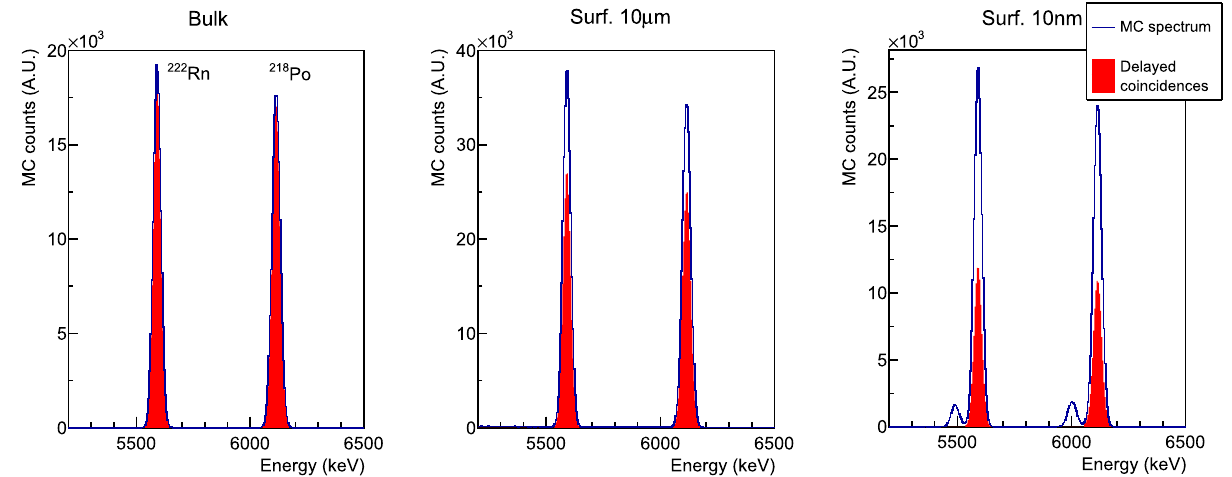
Fig. 5 Monte Carlospectraof 238 Udecaychain, zoomedon 222 Rnand 218 Popeaks,obtainedbysimulatingthecontaminantsinthecrystalbulk (left), and on crystal surfaces with depth parameters of 10 μ m (center) and 10 nm (right). The fraction of 222 Rn– 218 Po delayed-coincidences (highlighted in red) over the total events recorded at the Q value peaks